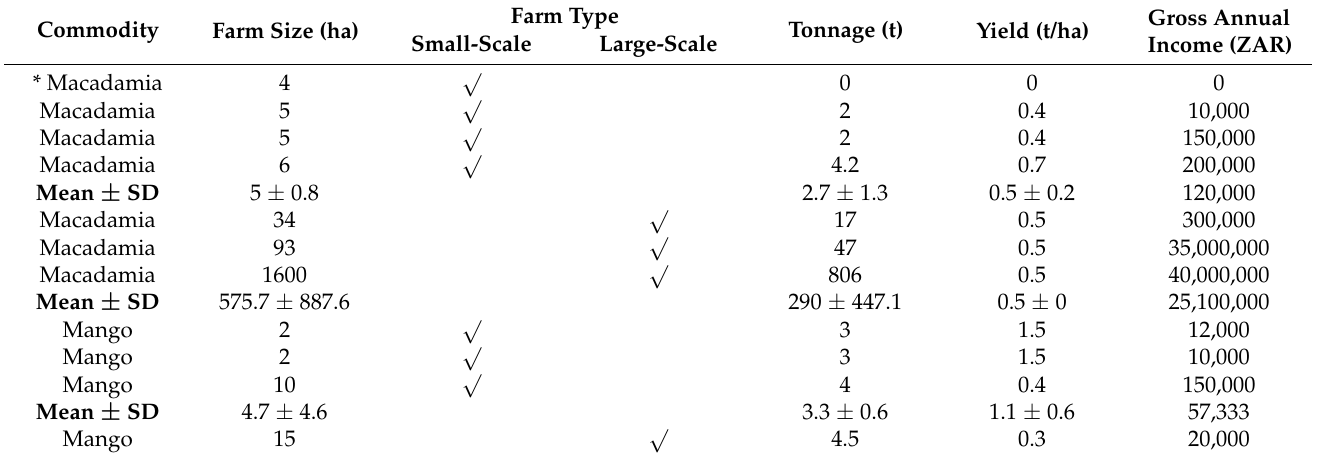
Table 1. Characterization of farm size, farm type, tonnage, yield and income by commodity for one year